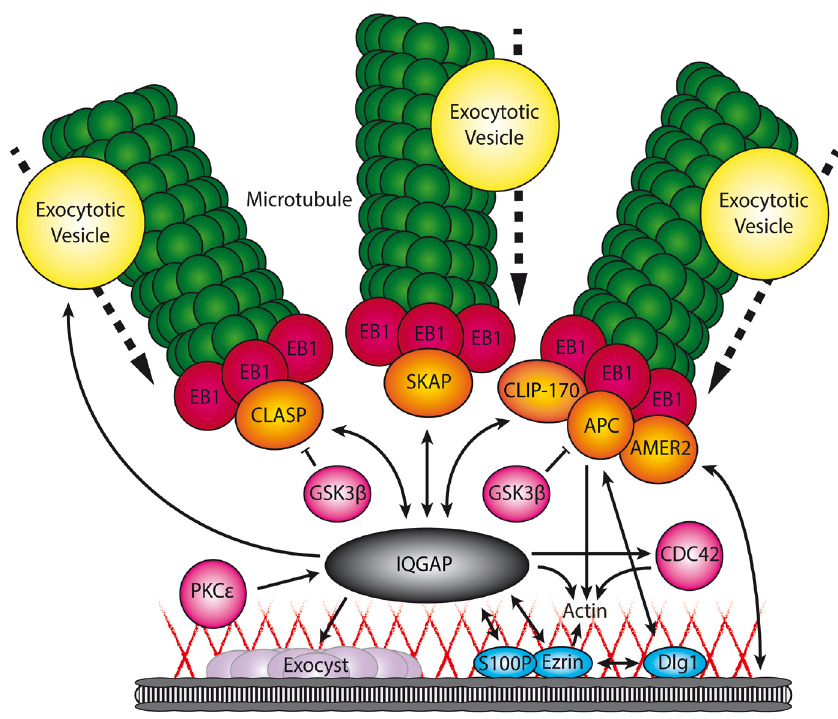
Figure 1. Schematic overview of IQGAP and associated protein functions in cortical microtubule capturing and exocytosis. Through its different domains, IQGAP interacts with a subset of microtubule plus-end tracking proteins (+TIPs) (orange) and cortical proteins (blue), thereby facilitating the microtubule capture at sites with high exocytotic activity. At the same time, IQGAP controls multiple components involved in secretion, including exocytotic vesicle-specific Rab GTPases (yellow), the exocyst complex (purple), and actin (red lines). Single- headed arrow, protein interaction with regulatory function; double-headed arrow, protein interaction facilitating recruitment; bar-headed line, negative regulation; dotted arrow, movement in direction of